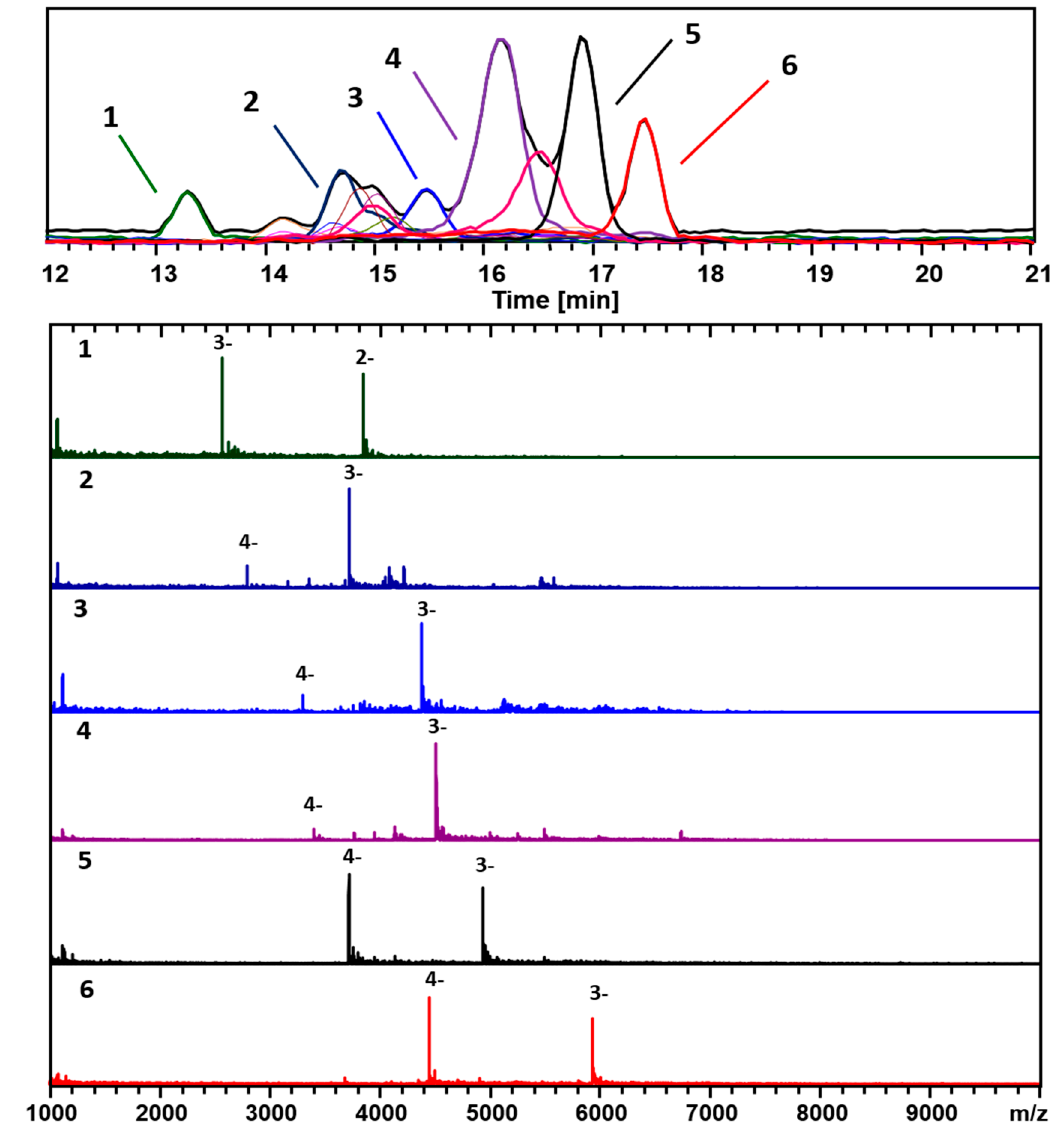
Figure 4. The analysis of the second preparation of 3-MBA clusters using the TEA–HFIP mobile phase buffer composition. The negative ionization mode was used for the analysis, mainly 3 − and 4 − charge-states. The black trace corresponds to the base peak chromatogram ( m / z 1000–10,000). The color-coded EIC chromatographic peaks track with coded and numbered mass spectra listed, and the compositions are assigned as follows: (1, Dark green) (25, 18), 7.7 kDa; (2, Dark Blue) (38, 24), 11.1 kDa; (3, Blue) (46, 26), 13.0 kDa; (4, Purple) (48, 26), 13.4 kDa; (5, Black) (53, 28), 14.7 kDa; and (6, Red) (67, 30), 17.8 kDa.